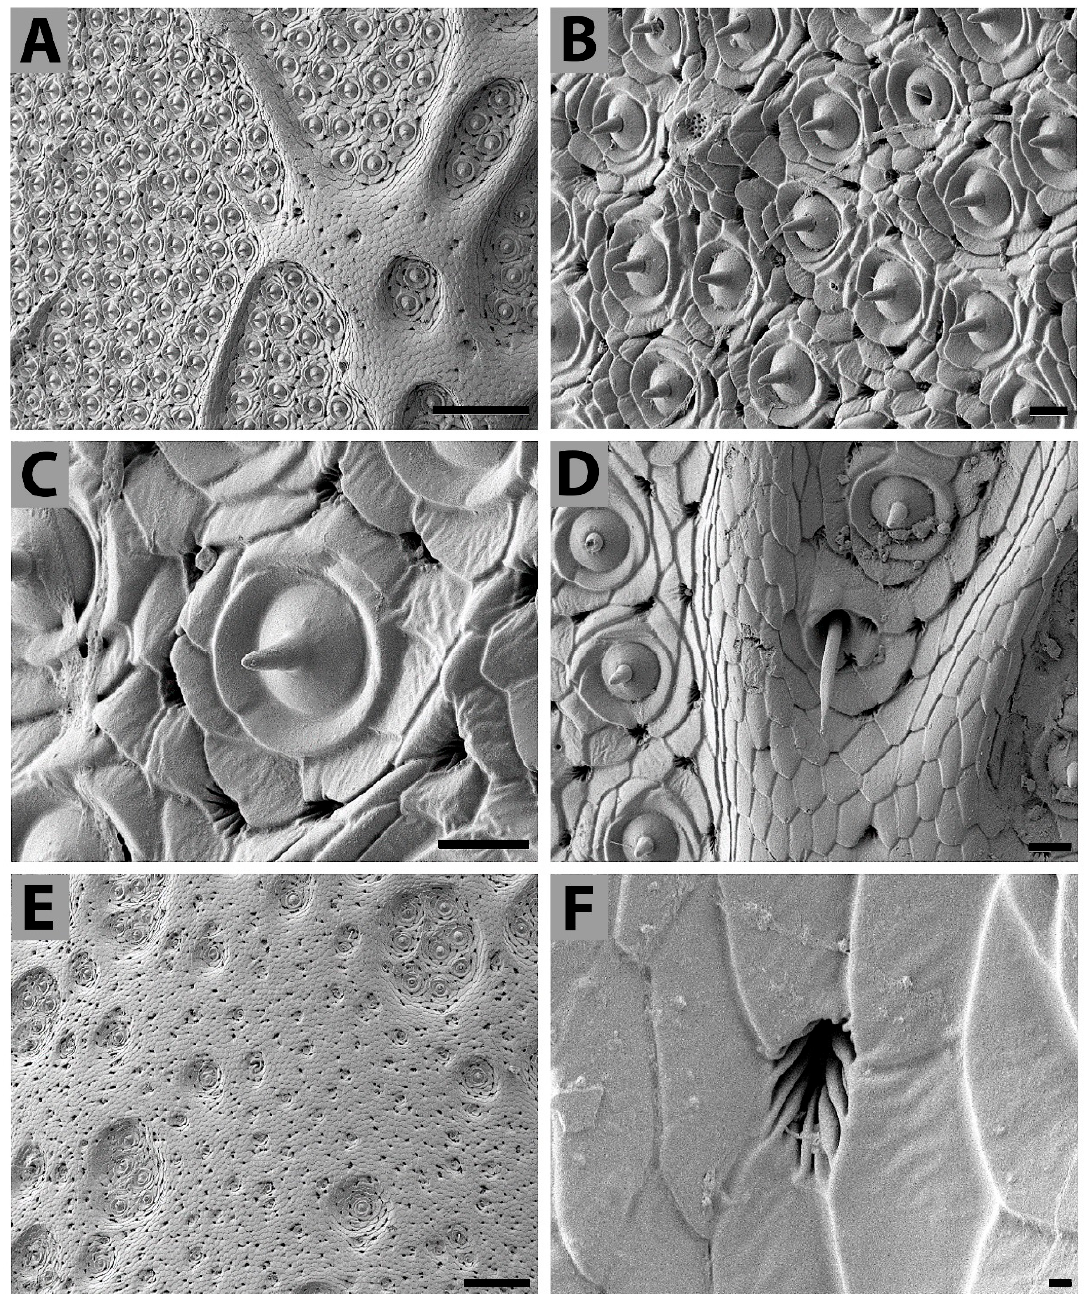
Figure 2. Scanning electron microphotographs of T. giganteus antenna. ( A )—General view on the coeloconic sensillar fields. ( B )—Detail of one sensillar field. ( C )—Individual coeloconic sensillum (surrounded with several rosette-like openings). ( D )—Two different types of antennal sensilla: trichoid sensillum (middle of the picture) and coeloconic sensillum. ( E )—Antennal cuticle outside of the sensillar field with numerous openings and individual or grouped coeloconic sensilla. ( F ) Detail view of the rosette-like opening. Scale bar: 100 μ m ( A , E ), 10 μ m ( B – D ); 1 μ m ( F ).